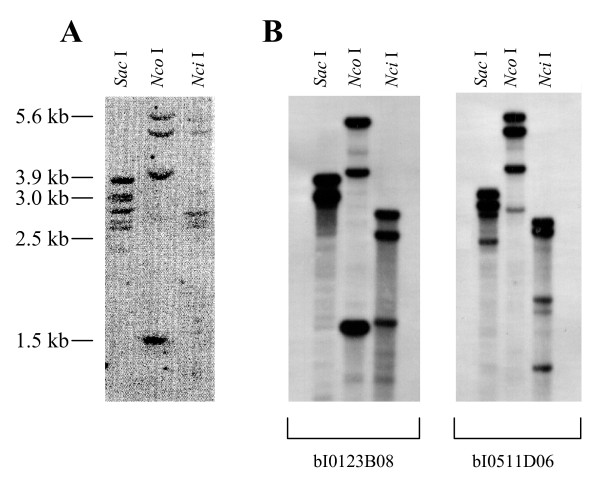
Southern blot analyses of bovine SERPINA3 organization. (A) Southern blot analysis of bovine genomic DNA digested with three different restriction enzymes NcoI, NciI and SacI. (B) Southern blot analysis of DNA from two overlapping BAC clones bI0123B08 and bI0511D06 digested with the same restriction endonucleases.